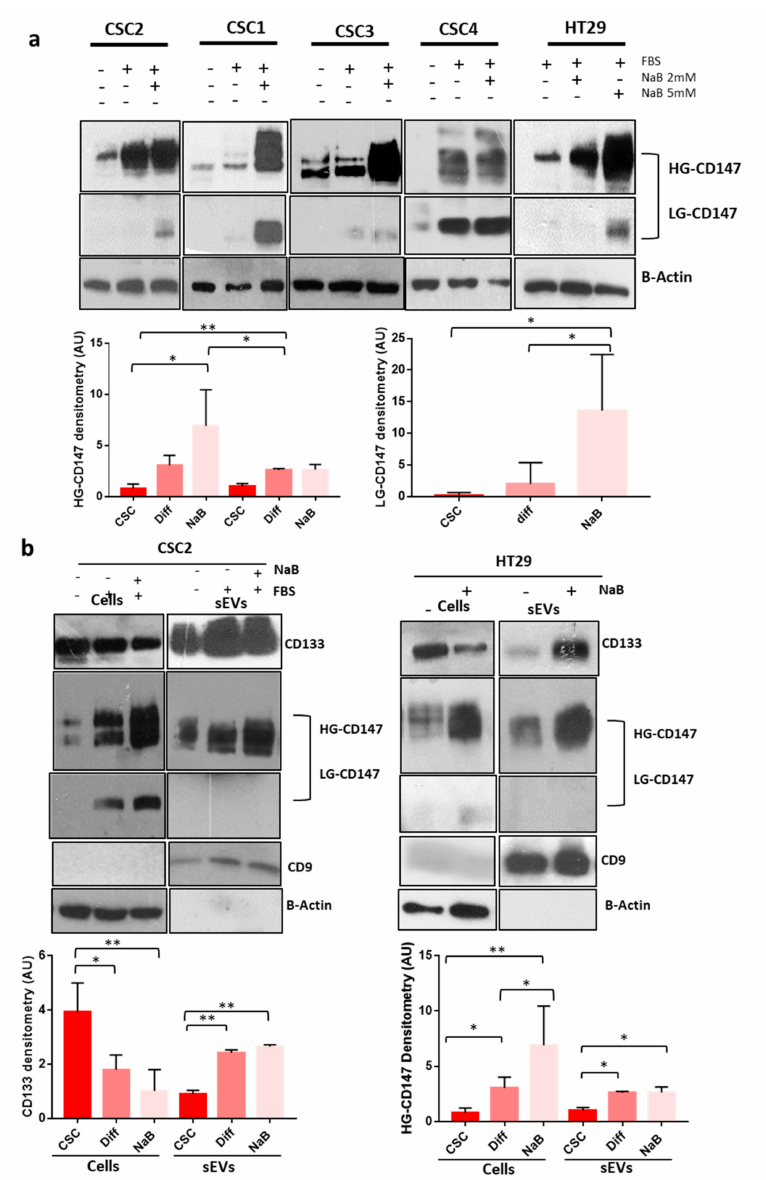
Figure 3. CD147 Expression Increases in CRC (colorectal cancer cells) and CR-CSC (colorectal cancer stem cells) Cell Lines Undergoing Di ff erentiation. ( a ) We evaluated CD147 expression in the HT29 CR cell line and in 4 CR-CSC lines. The di ff erentiation induced an increase of CD147 expression in both glycosylation forms (LG-CD147 and HG-CD147) in all cell lines tested. Bar charts show the densitometry analysis and statistical analysis of CD147 bands in the Re121 CR-CSC and in the HT29 CRC cells lines. ( b ) CD133 and CD147 expression increased in sEVs released by CR-CSCs and HT29 cells lines undergoing di ff erentiation. Bar charts show the densitometry analysis and statistical analysis of both CD133 and CD147 bands in cells and sEVs (small extracellular vesicles) extracts of sEVs of Re121 CR-CSC line undergoing di ff erentiation Data are representative of three independent experiments. Di ff = CR-CSCs grow with 10% of FBS (Fetal Bovine Serum) and in absence of growth factors; NaB 2 mM = CR-CSCs grow with 10% of FBS, in absence of growth factors and after seven day (adhesion condition) treated with 2 mM of NaB for 48 h or HT29 treated with 2 mM of NaB for 48 h; NaB 5 Mm = HT29 treated with 5 mM of NaB for 48 h. Analysis of CD9 was used to confirm the correct isolation of sEVs. *, p ≤ 0.05; **, p ≤